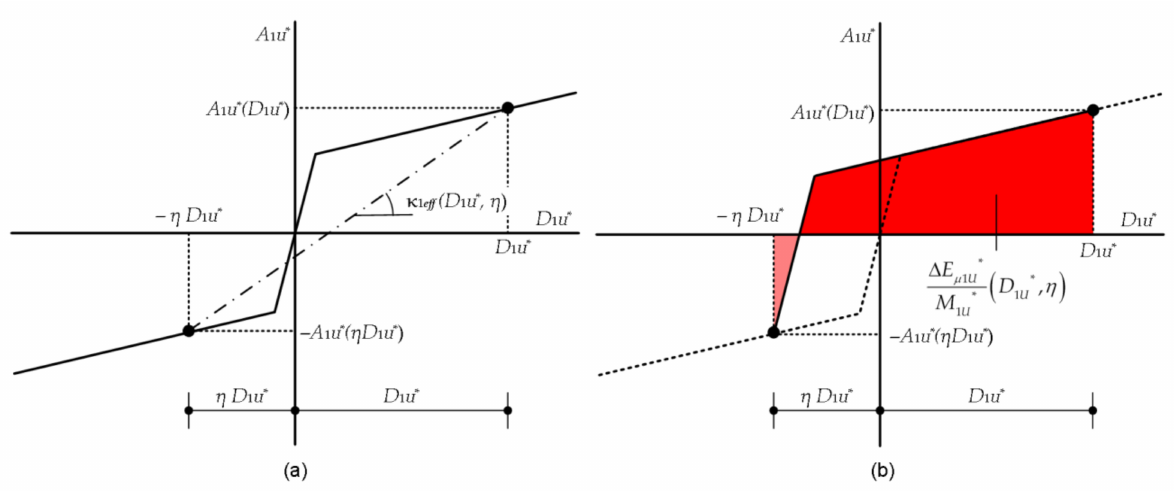
Figure 3. Modeling of the structural response in a half cycle used to predict the peak response: ( a ) The effective slope ( κ 1 eff ) and ( b ) the hysteretic dissipated energy in a half cycle per unit mass ( ∆ E µ 1 U / M 1 U *